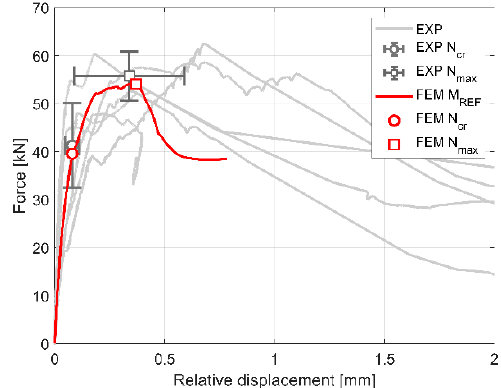
Figure 10. Experimental and numerical (reference model) load–relative displacement responses of the walls.